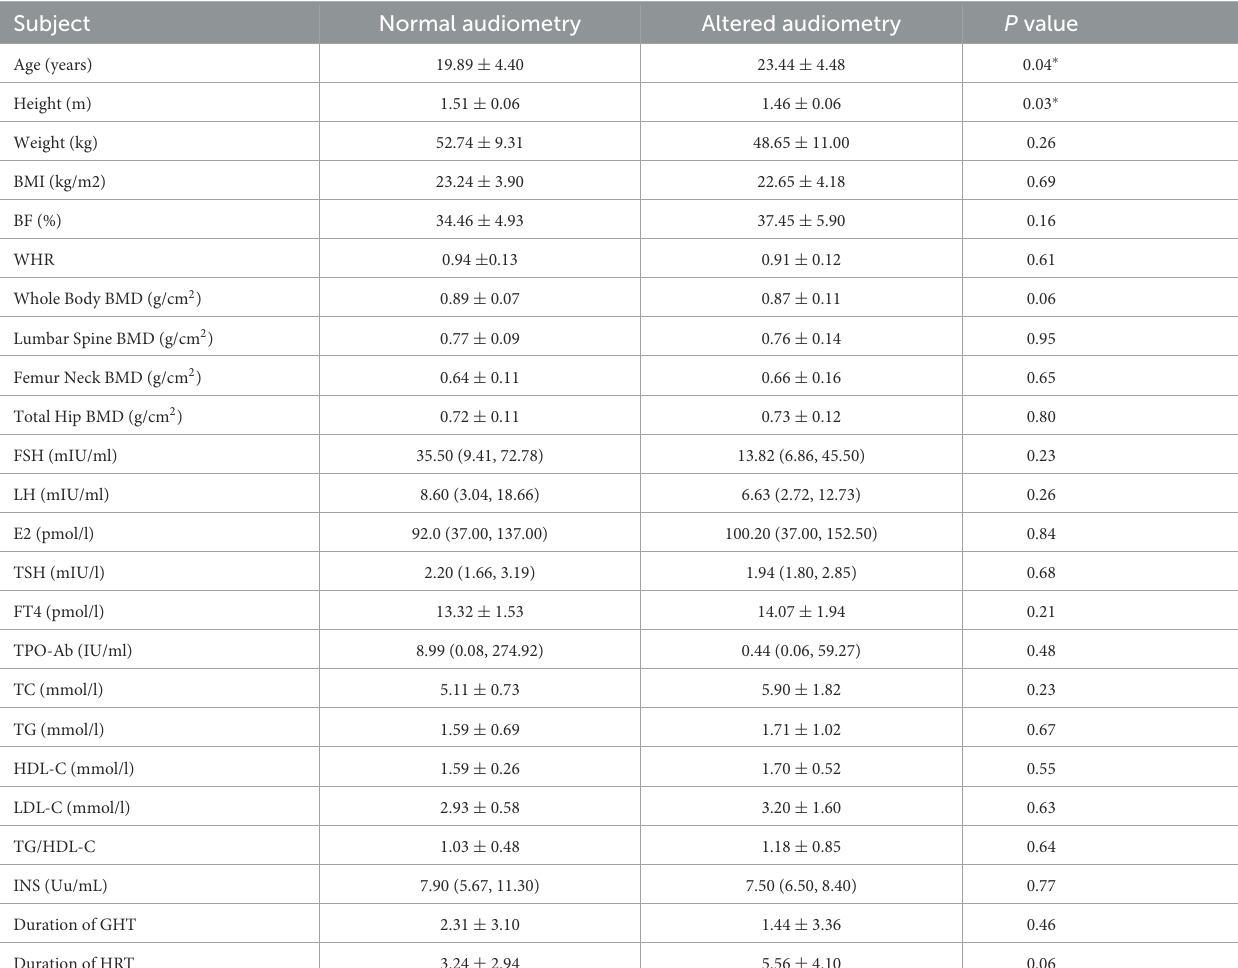
TABLE 5 Factors associated with hearing loss.